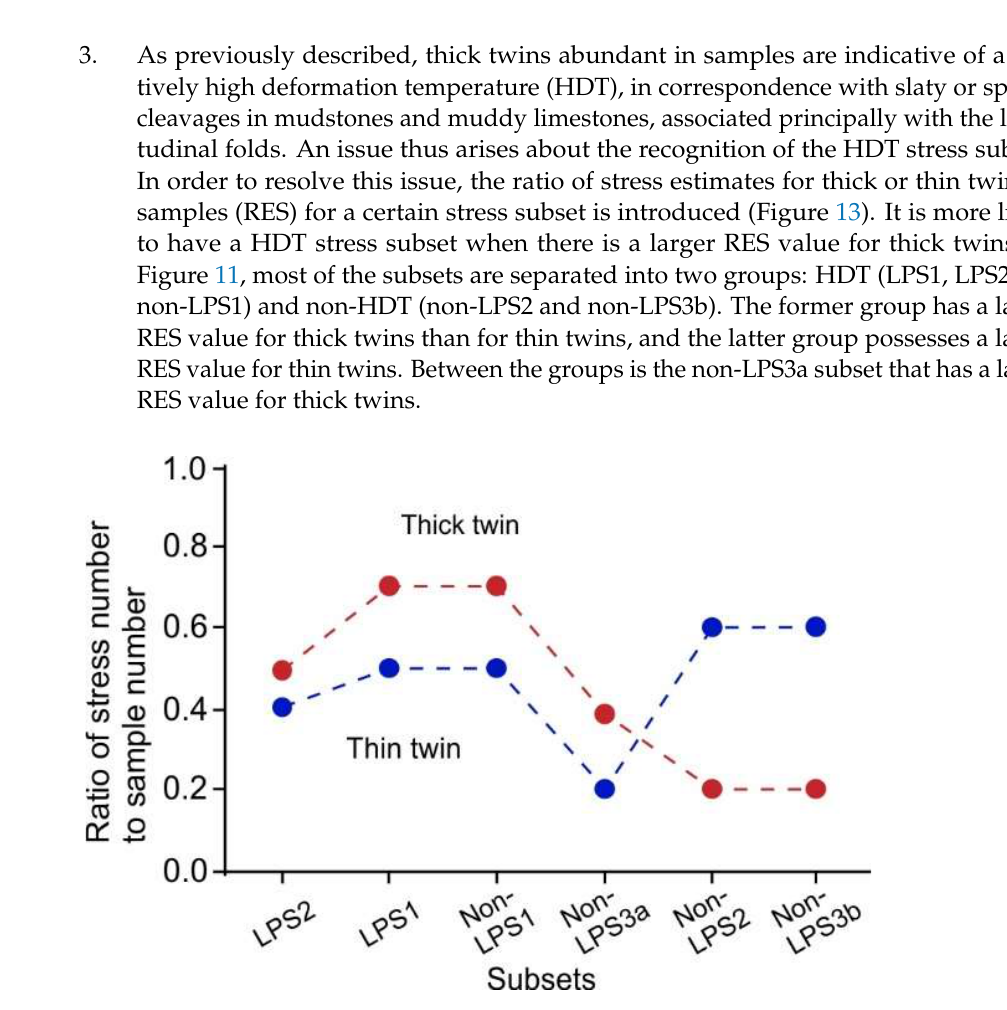
Figure 13. The ratio of stress estimates for thick and thin twins to samples for a certain stress subset. Based on these considerations the stress subsets are rearranged in a younging and temperature-decreasing order and further grouped into three stages (Figure 14): folding in the Middle–Late Triassic (LPS1, LPS2, non-LPS1 and non-LPS3a), refolding in the Late Jurassic–Early Cretaceous (non-LPS2) and extension in the Cretaceous (non-LPS3b). How- ever, there are some uncertainties regarding this arrangement. Whether the LPS1 is older or younger than the LPS2 is yet unknown and requires additional observations. The non- LPS3a is placed immediately after the non-LPS1, since the former extension, approximately parallel to the longitudinal fold axes, is considered as a product of relaxation of strain accu- mulated by the latter intense deformation. Interestingly, its minimum principal stress axis is nearly perpendicular to the strikes of the most economically important Au-Sb-bearing quartz veins in the basement core. These veins are vertical and WNW-striking and have a 40 Ar– 39 Ar age of 161.1 ± 1.2 Ma